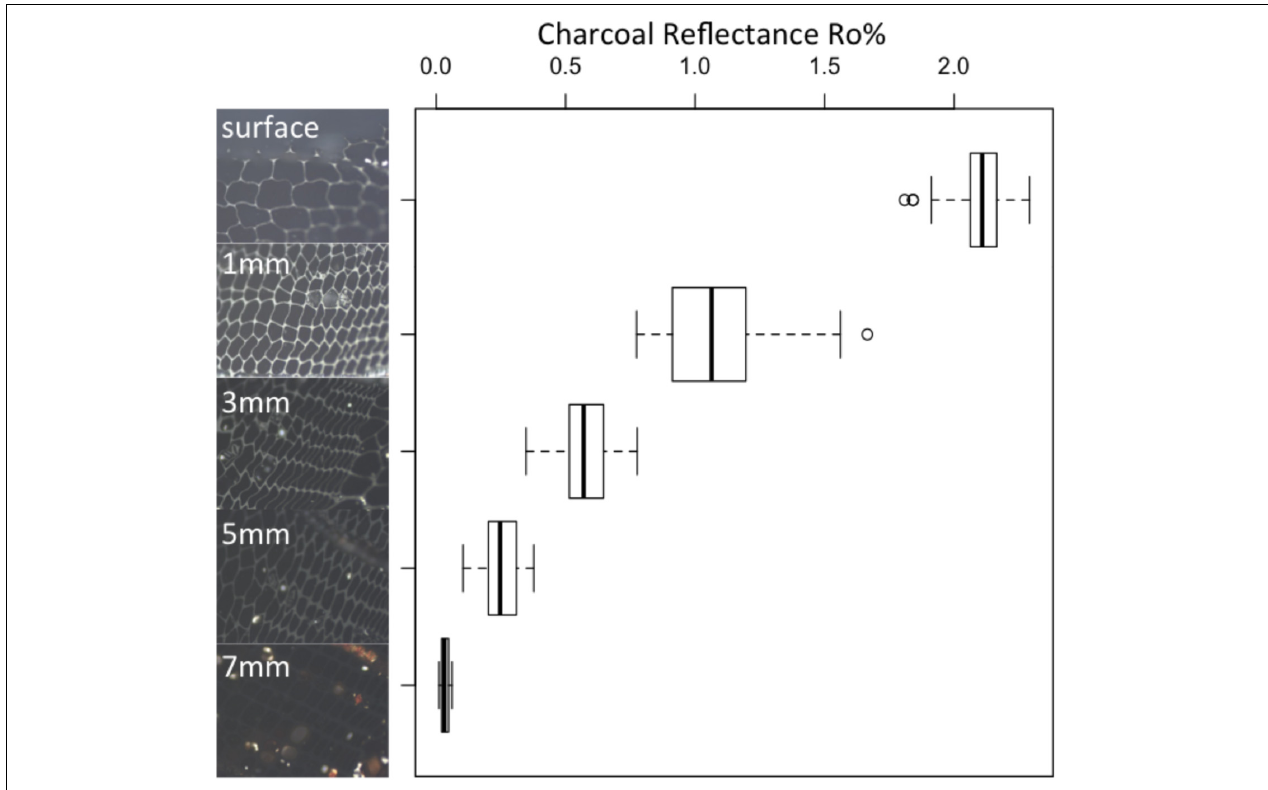
FIGURE 5 | Reflectance images and box plots ( n = 90 for each box) showing the variations in charcoal reflectance with depth in a charred block of WRC. Indicating that charcoal reflectance decreases away from the heated sample surface and into the char layer.